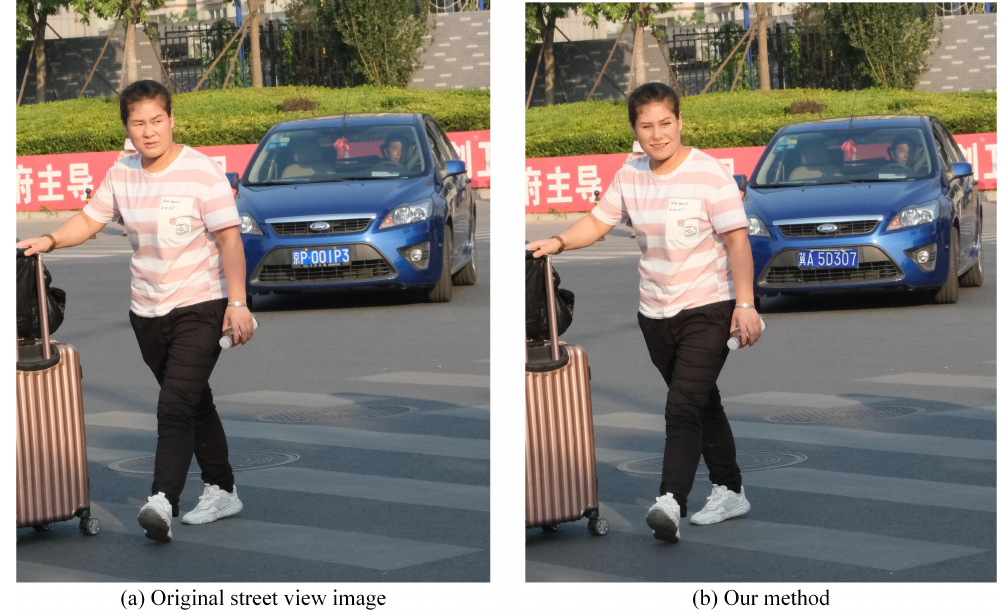
Figure 12. A typical Chinese car plate swap to protect the private information in street view image: ( a ) Original street view image. ( b ) Our